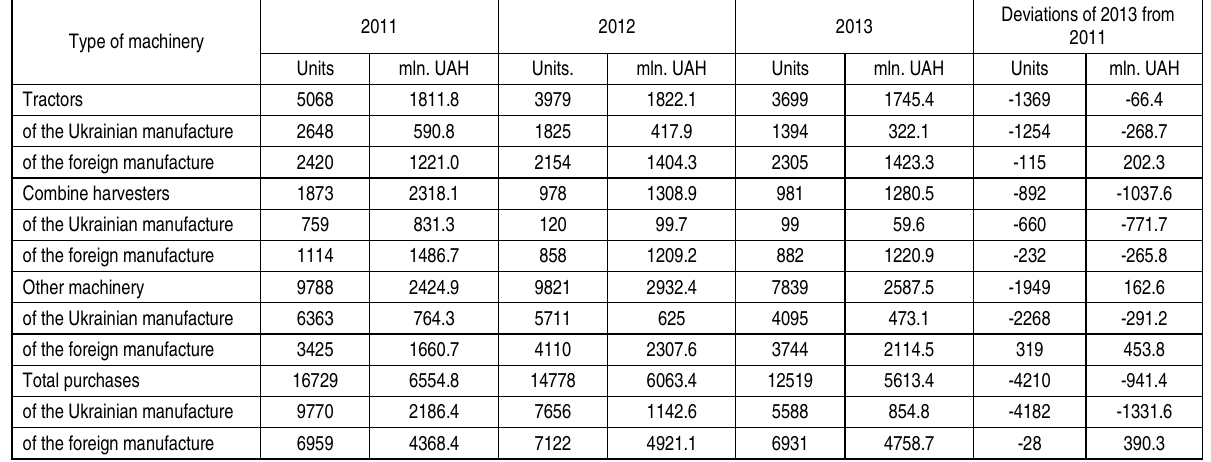
Table 7. Purchasing of agricultural machinery in